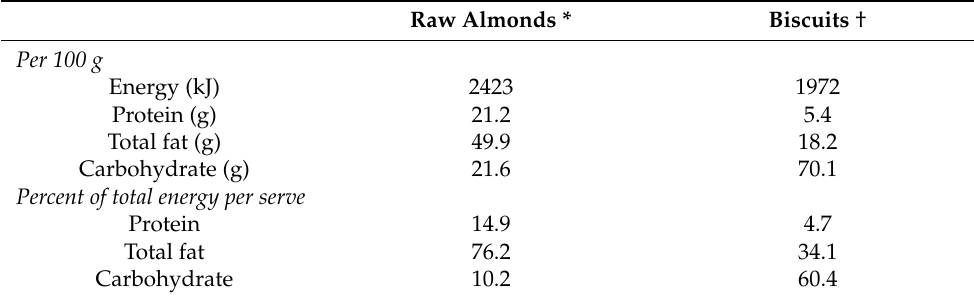
Table 1. Nutritional composition of the study snack food expressed per 100 g and as a percent of total